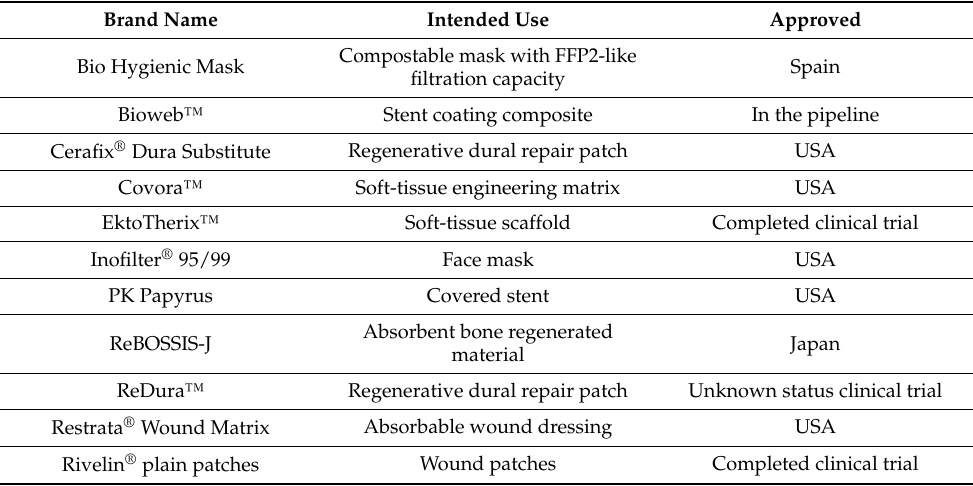
Table 2. Examples of commercially available electrospun medical